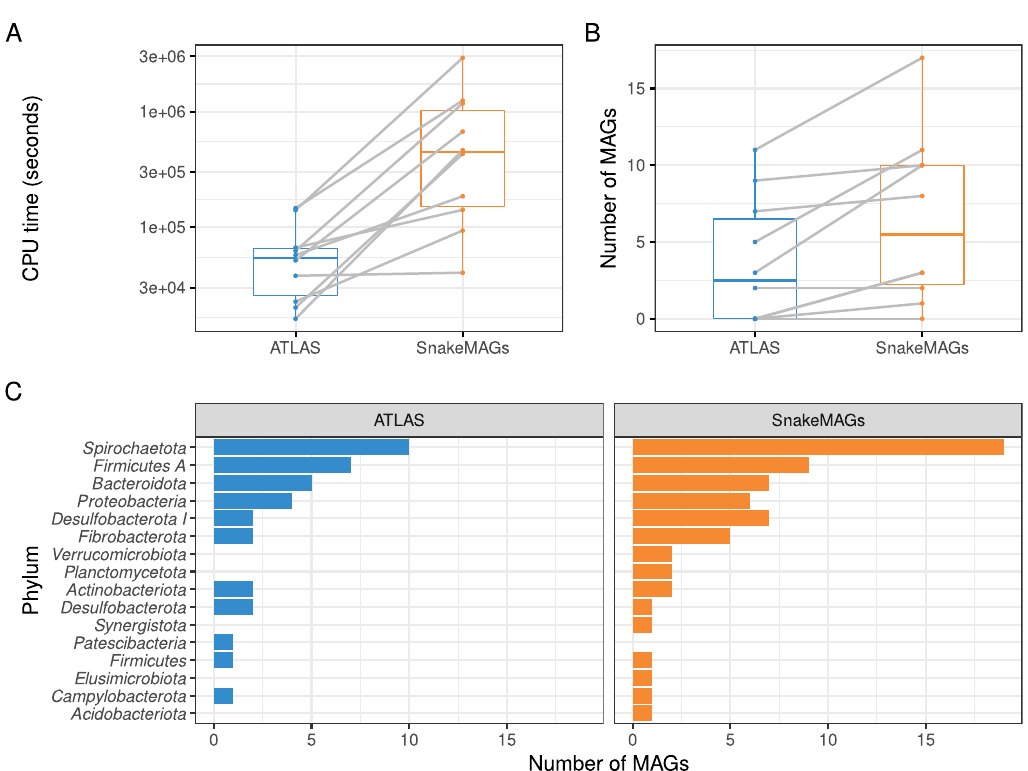
Figure 2. Comparison of the performance of SnakeMAGs v1.1.0 with another workflow, namely ATLAS v2.9.1 14 using10termitegutmetagenomes. A.CPUtime(inseconds)requiredtoprocesseachmetagenome.B.Numberof MAGs reconstructed from each metagenome. On both boxplots, gray lines link the result obtained with ATLAS and theoneobtainedwith SnakeMAGs foreachofthe10analyzedtermitemetagenomes.C.NumberofbacterialMAGsat the phylum level recovered from each